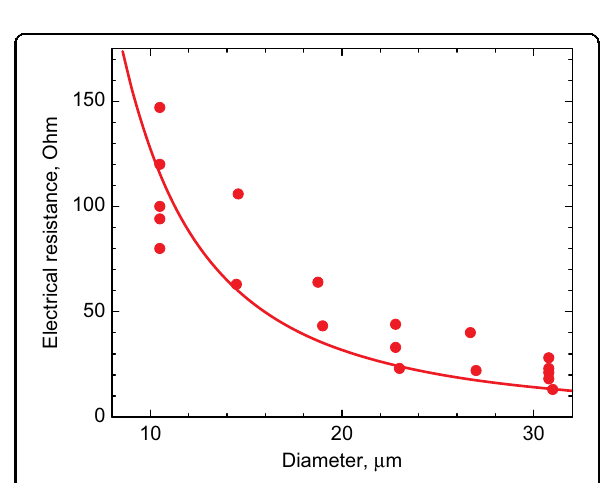
Fig. 4 Electrical resistance. Series electrical resistance of QWD-on- GaAs microdisk lasers as a function of diameter; line correspond to speci fi c resistance of 10 − 4 Ω × cm 2